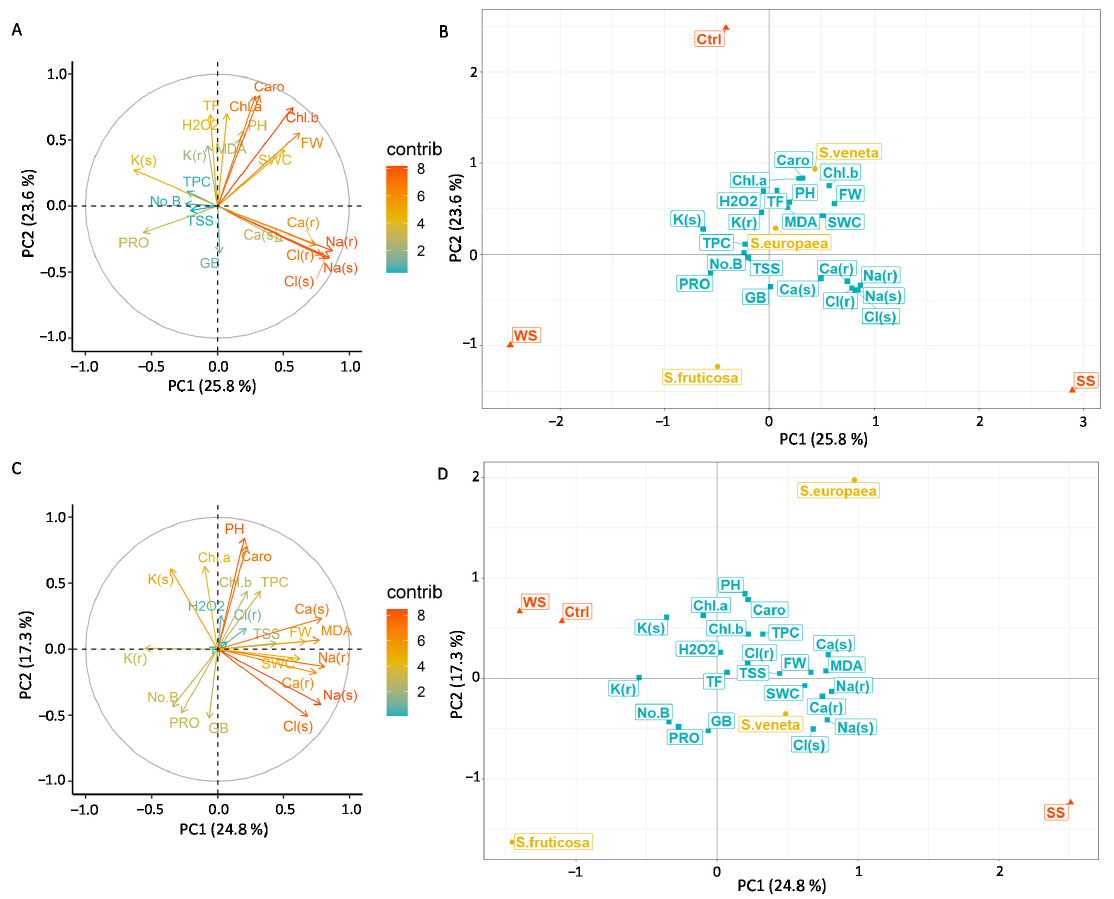
Figure 9. PCA correlation circles of the 22 measured parameters: ( A ) after 30 days of stress treatments (PCAstress) and ( C ) after 15 days of watering with non-saline water (PCArecovery). The increasing arrow lengths and shades of colour from light blue to red indicate the increasing contribution of variables to the definition of the first two principal components. PCA biplot of variables ( B ) after 30 days of stress treatments (Stress) and ( D ) after 15 days of watering with non-saline water (Recovery). Yellow circles show the barycentres of the three halophyte species ( S. europaea , S. veneta , S. fruticosa ), orange triangles show the barycentres of the three experimental treatments (Ctrl, control; SS, salt stress (watering with 700 mM NaCl water solution); WS, water stress (complete withholding of irrigation)), and the light blue squares show the quantitative variables, i.e., the measured traits (fresh weight (FW), shoot water content (SWC), plant height (PH), number of branches (No.B), chlorophyll a (Chl. a), chlorophyll b (Chl. b), carotenoids (Caro), root sodium concentration (Na(r)), shoot sodium concentration (Na(s)), root chloride concentration (Cl(r)), shoot chloride concentration (Cl(s)), root potassium concentration (K(r)), shoot potassium concentration (K(s)), root calcium concentration (Ca(r)), shoot calcium concentration (Ca(s)), glycine betaine (GB), proline (PRO), total soluble sugars (TSS), malondialdehyde (MDA), hydrogen peroxide (H 2 O 2 ), total phenolic compounds (TPC), total flavonoids